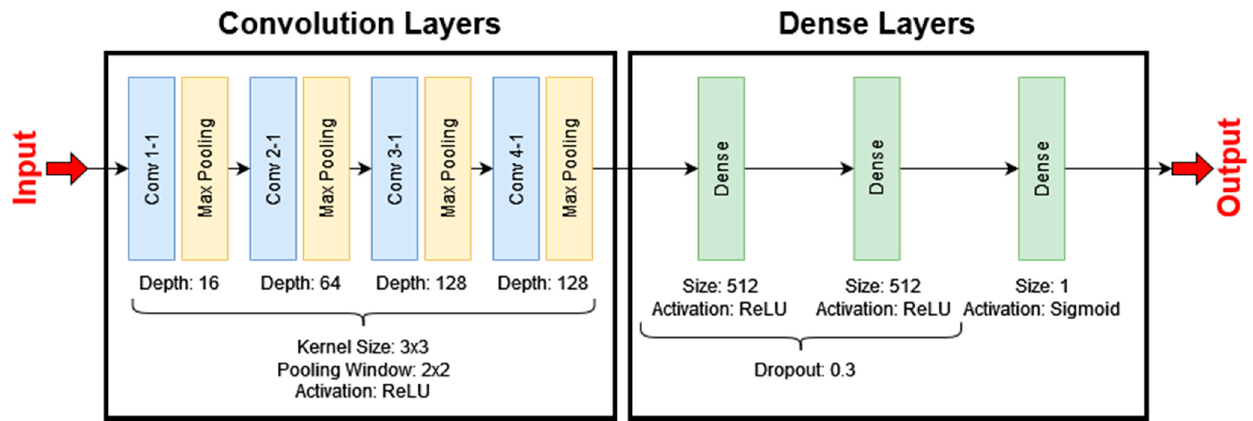
Figure 4. Rudimentary CNN model architecture.